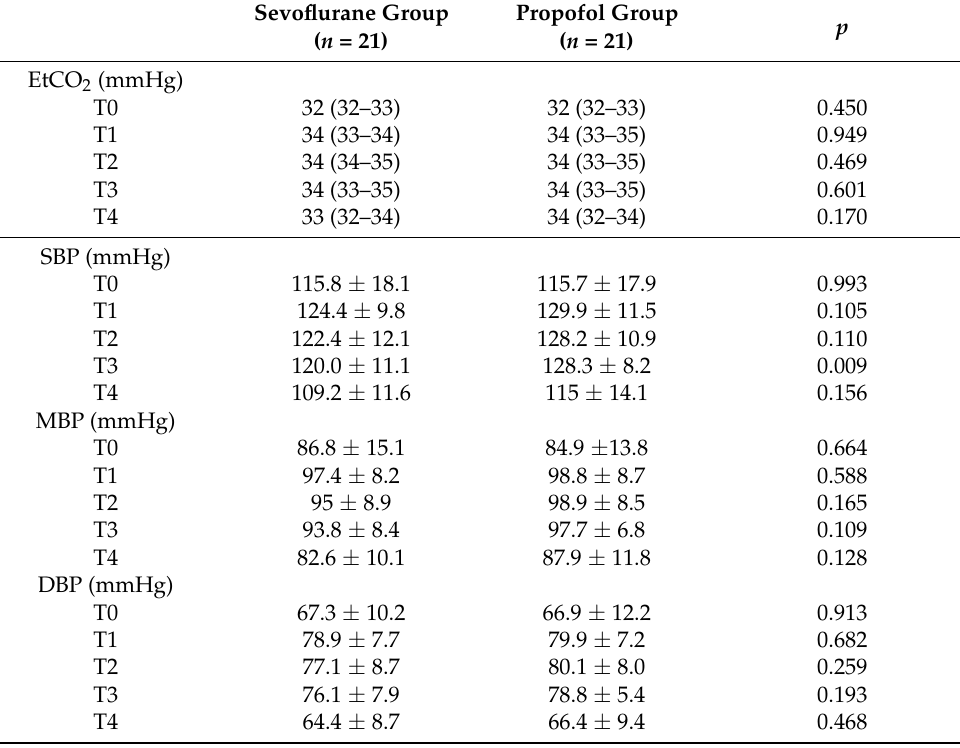
Table 3. Comparison of respiratory and hemodynamic parameters between two